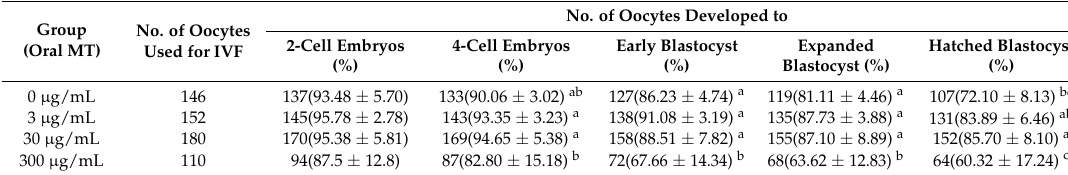
MT: melatonin; IVF: in vitro fertilization. Percentage data are presented as the mean ± SD from at least 3 replicates. Values with different superscripts (a, b and c) within each column differ significantly ( p < 0.05).